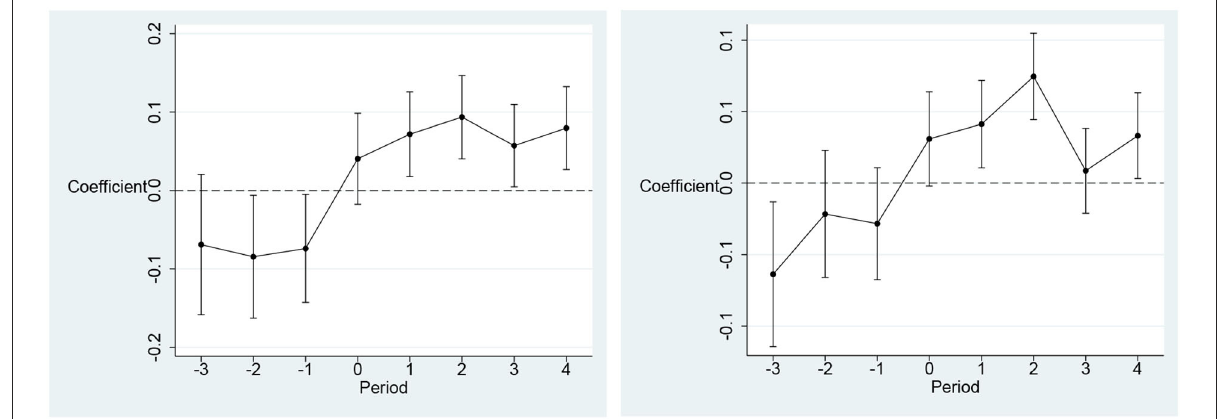
FIGURE5 Results of Parallel Trend Test. The dependent variable in the left panel is medical workforce (ln mw ) and the dependent variable in the right panel is medical infrastructure (ln mi ). The X-axis denotes the window period for BCCP implementation. The Y axis represents the regression coefficient of BCCP. The year before BCCP is implemented as the base period.